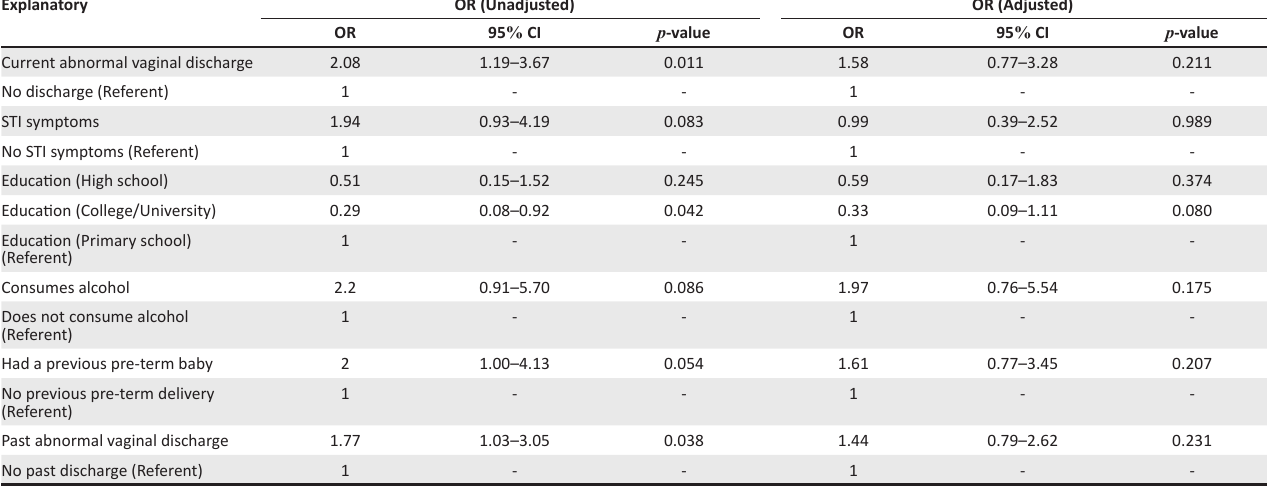
TABLE 2: Univariate and multiple regression analysis of risk factors associated with Mycoplasma hominis infection. Explanatory OR